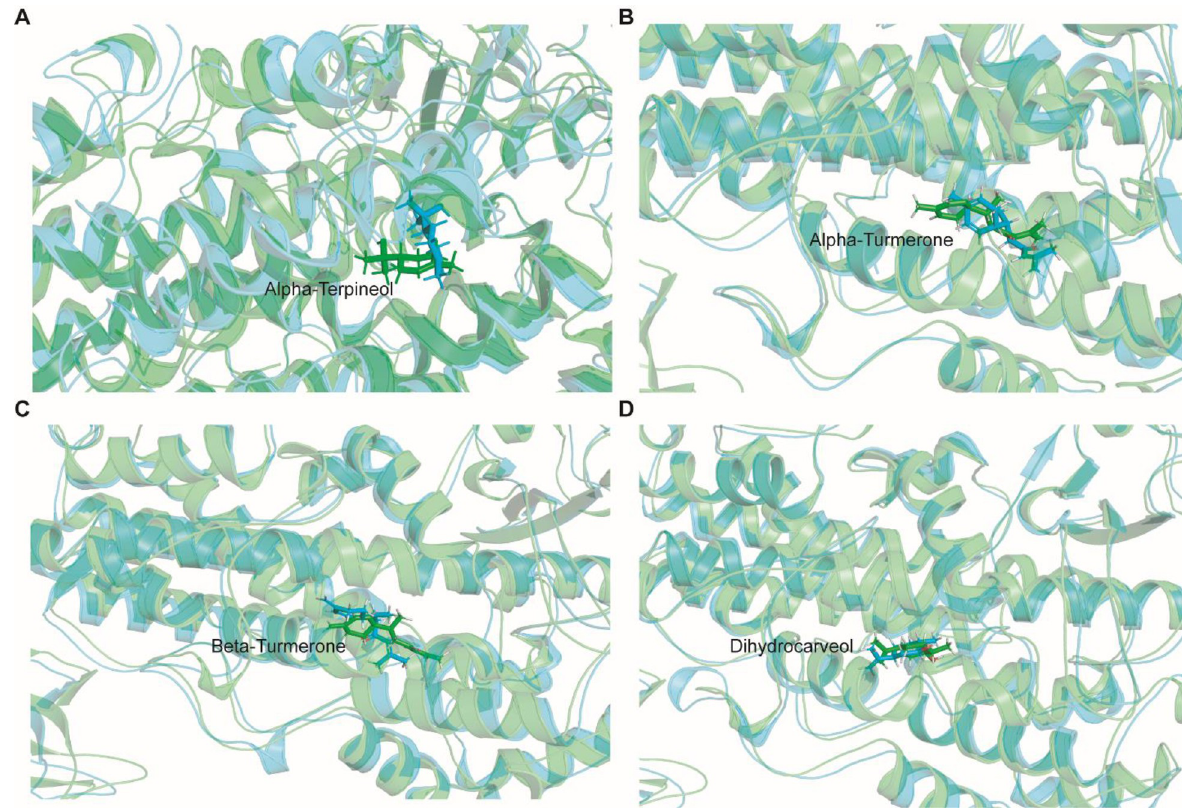
Fig 6. Structural superimposed view of the pre (green) and post-MD (cyan) snapshots displaying the orientation of ligands within the binding pocket of 5-LOX protein.